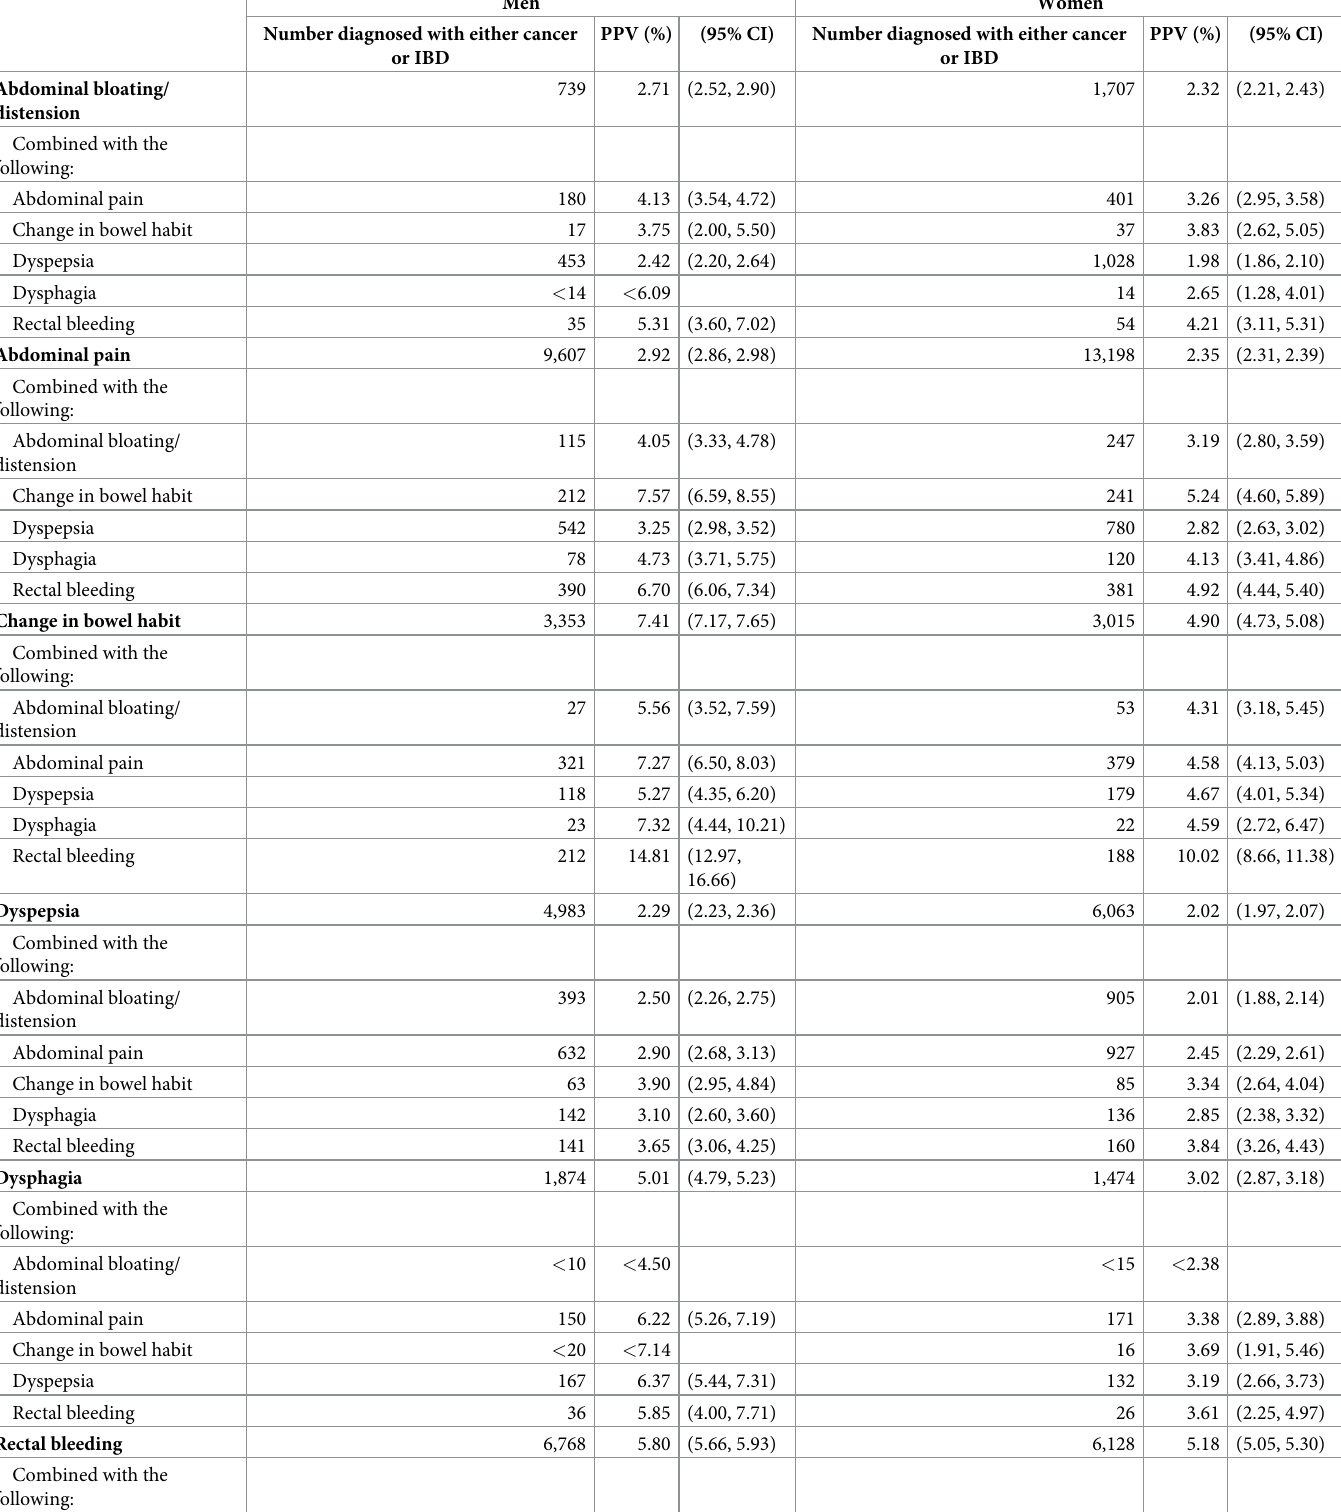
Table 3. Numbers of incident cases and PPVs (95% CIs) for the composite outcome of either cancer or IBD in the year following each studied abdominal